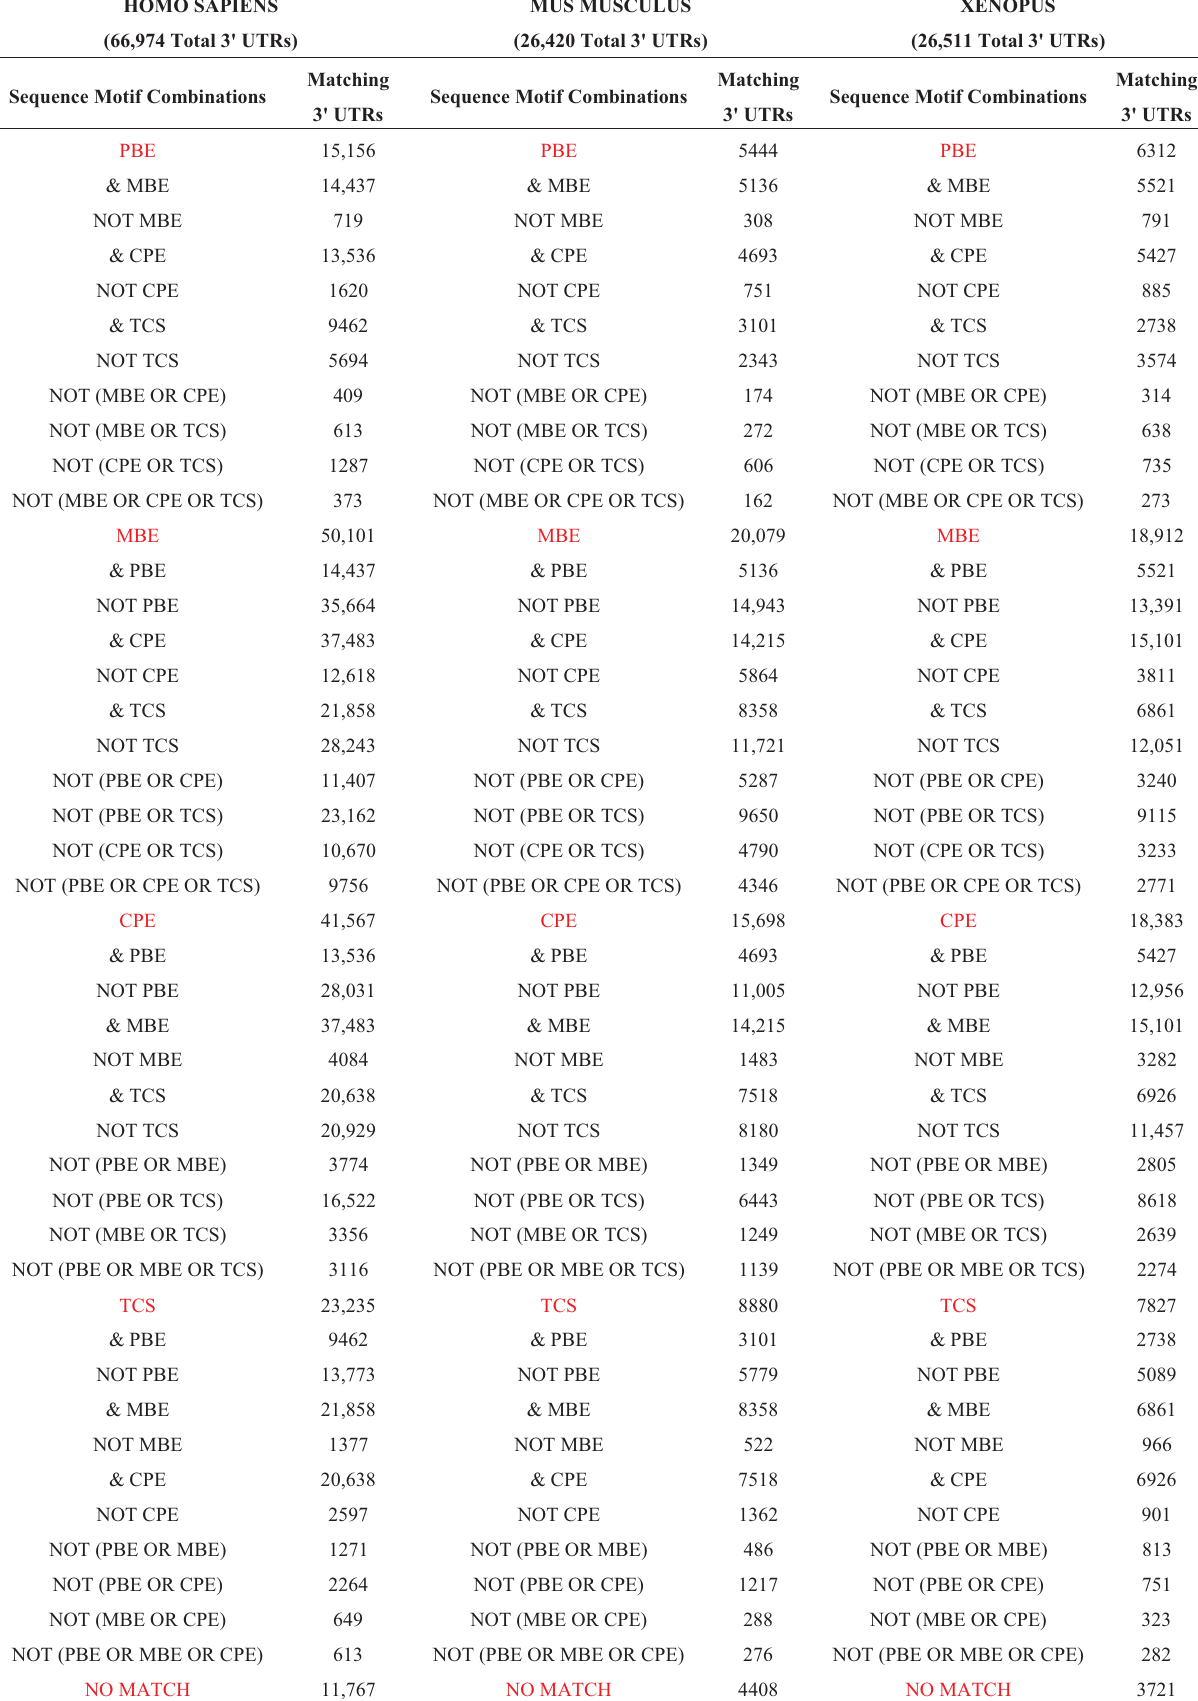
Table 1. Vertebrate mRNA 3' UTRs commonly contain multiple distinct regulatory elements. HOMO SAPIENS (66,974 Total 3' UTRs)